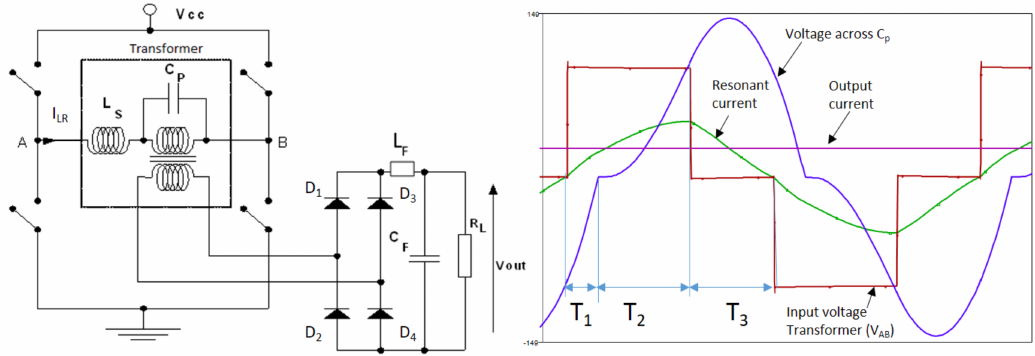
Figure 6. Power topology and main waveforms: voltage at the transformer input (red), current through series inductor Ls (green), and voltage across the parallel capacitor (violet) and output current